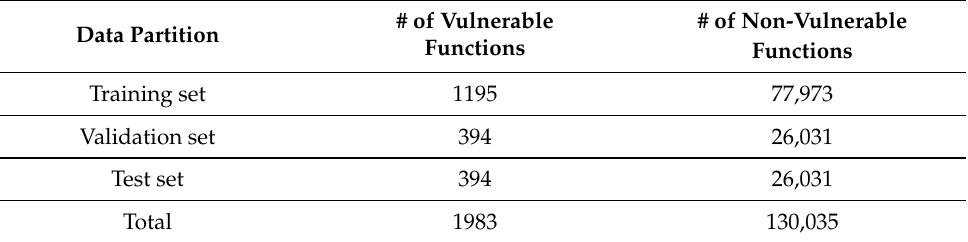
Table 4. The experiment setting for answering RQ1-3, listing the partitioned data set of 12 real-world open-source projects for training, validation, and